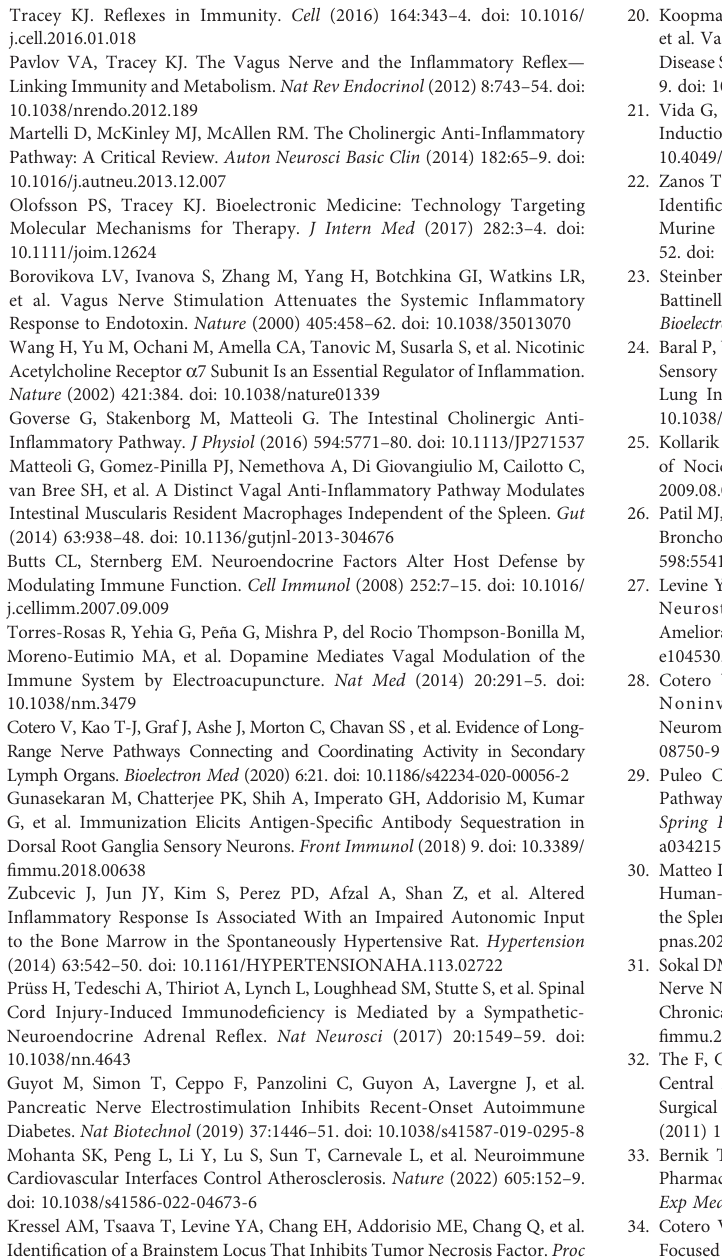
stimulation at 16 hours. (B) Same as (A) , but in bacteria instilled animals at 4 hours, 16 hours, and 48 hours timepoints (Paired t-test). Asterisk indicates p <0.05. Supplementary Figure 11 | Hematoxylin and Eosin stain from lung tissues sampled from bacteria infected and saline control rats. (A) The lungs were collected during autopsy and sectioned at 20 um thickness using a cryosection machine. The sections were stained with hematoxylin and eosin stain. The left panels show microscopic images ofthe right lung. The right panels show images ofthe leftlungs.